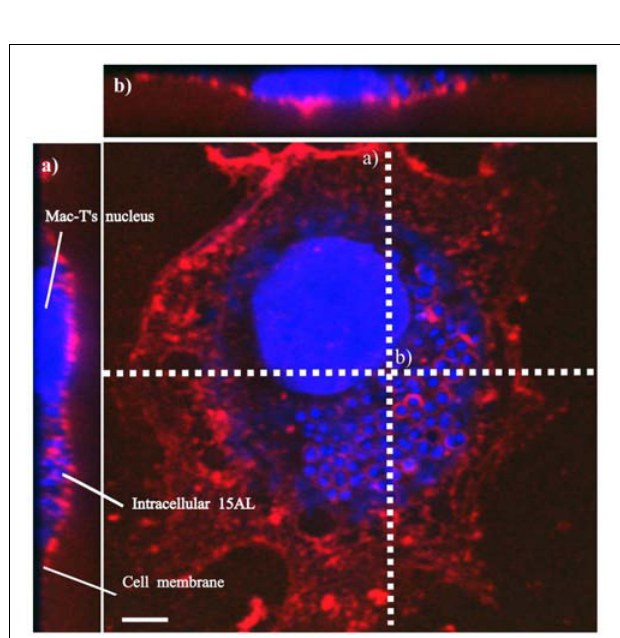
FIGURE 3 | Localization of S. aureus in Mac-T cells. Invasion of S. aureus 15 AL in Mac-T cells was visualized using confocal microscopy. Prior to imaging, cells were stained with DAPI (blue) for epithelial cells and 15 AL DNA staining and WGA (red) for host cells membrane staining. Confocal microscopy z -stack projection moved through 139 slices across the cell. (a) Horizontal cross-section of Mac-T cells (b) Vertical cross-section of Mac-T cells. The small blue dots are S. aureus 15AL cells inside Mac-T cells, indicating invasion. White scale bar is 7.5 µ